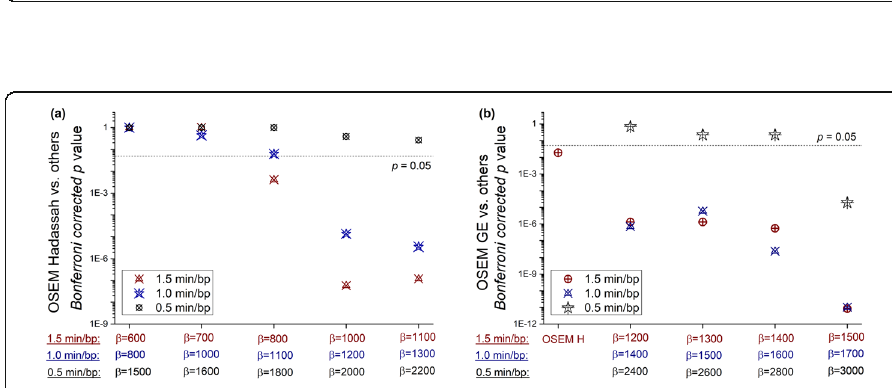
Fig. 6 p values (non-parametric one-tail sign test) of the improvement in the mean score of all rated aspects between reconstructions using Q.Clear and a Hadassah OSEM or b GE OSEM